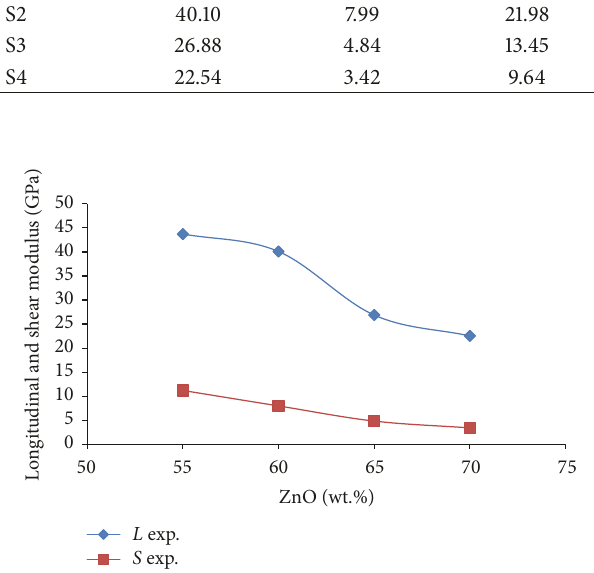
Figure 4: Longitudinal and shear modulus versus wt.% of ZnO in ZnO–SiO 2 samples.